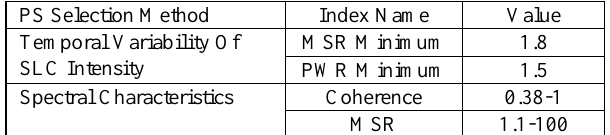
Figure 6. Double bounce(cubes in green color) on the (a) arc and (b) road of the Lupu Bridge. Note that there are sightseeing pavements on both sides of the arc and railings beside pavements and lanes.